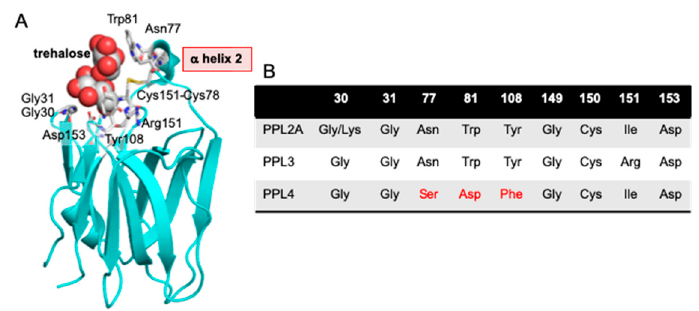
Figure 2. Aligned amino acid sequences of PPL3 and PPL4 subunits with jacalin-related lectins. The sequences were aligned using the Clustal W program [25] and represented by using BOXSHADE 3.21. The residues identical to the column-consensus are presented by inverse character (black background), while the residues which are not identical, but at least similar to the column-consensus, are presented by gray background. C1 to C6 indicates the half-cysteine residues with inter- and intra-disulfide bonds. Secondary structural elements, β strands ( β 1– β 9) and α helixes ( α 1 and α 2), identified in the 3D structure of PPL3s [24] are shown as blue arrows and red boxes, respectively. The GG loop, the recognition loop, and the binding loop, indicated by arrows, are parts of the carbohydrate recognition domain. Asterisk (*) indicates the amino acid residues taking part in the interaction with carbohydrates found in the three-dimensional (3D) structure of PPL3s.